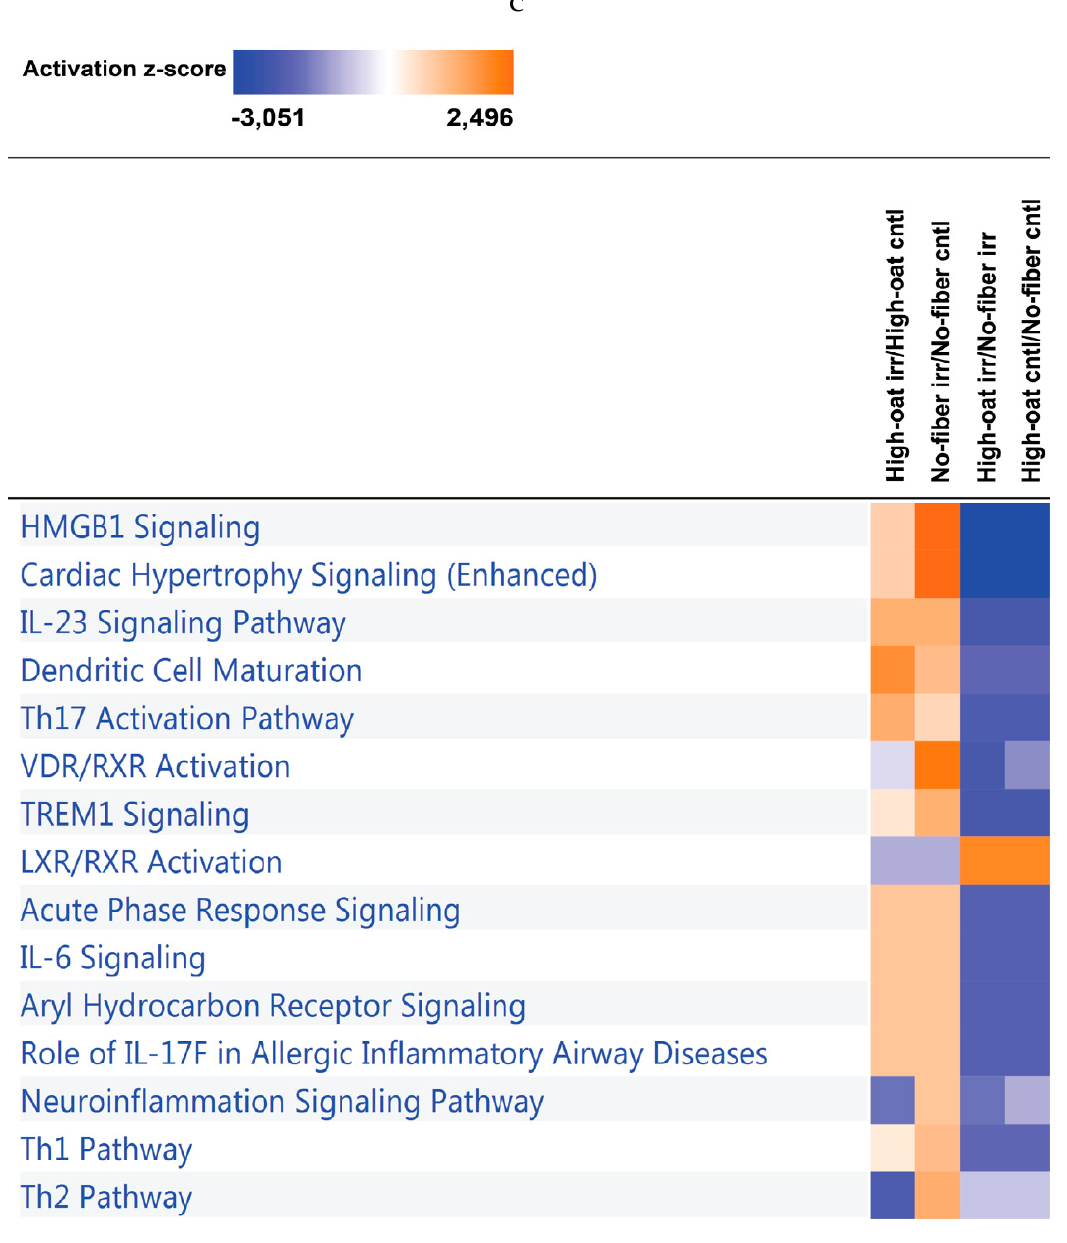
Figure 8. Pathway enrichment analysis. The comparison analysis was used to compare the High-oat irr vs. High-oat cntl, No-fiber irr vs. No-fiber cntl, High-oat irr vs. No-fiber irr, and High-oat cntl vs. No-fiber cntl groups, to observe the top 15 canonical pathways associated with the cytokine profiles at ( A ) 1, ( B ) 6, and ( C ) 18 weeks post-irradiation, ordered according to the highest activation z-score. The orange colorations indicate upregulation of the pathway and the blue colorations indicate downregulation of the pathway.